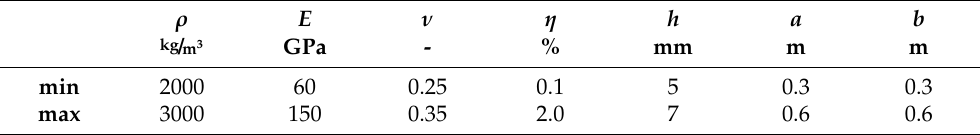
Table 1. Design space with set of interest used to sample supporting